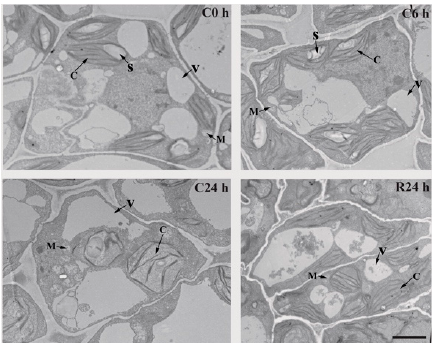
Figure 2. The ultrastructures of leaves at different treatment condition (C0 h, C6 h, C24 h, R24 h) from J. curcas seedling. The bar equals 2 μ m. C, chloroplast; M, Mitochondria; S, starch granules; V, vacuole.